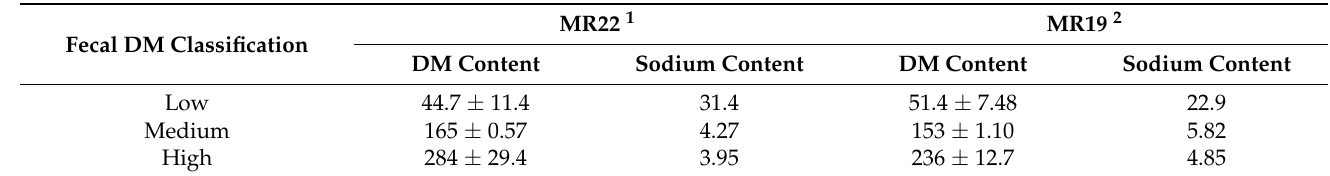
Table 6. Dry matter (DM) content (g/kg) and sodium content (g/kg DM) depending on fecal DM classification and crude protein content of MR (mean ± SD).